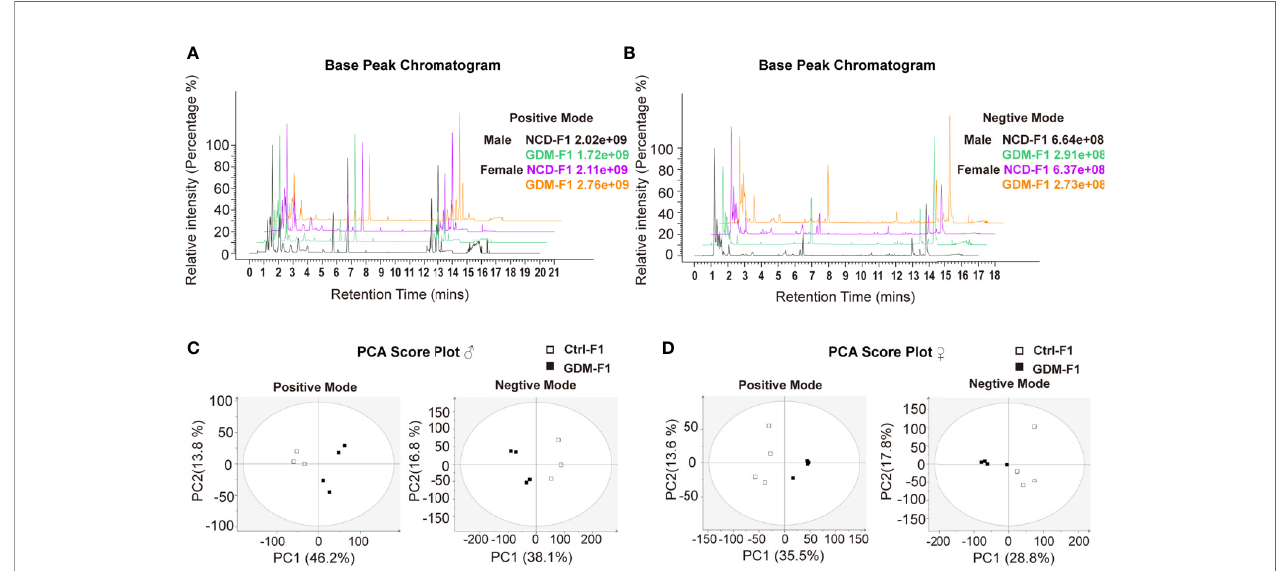
FIGURE 2 | BPI chromatograms and PCA score plot of UPLC-MS of fetal pancreas. (A) Representative positive BPI chromatograms of GDM-F1 and Ctrl-F1 fetal pancreas. (B) Representative negative BPI chromatograms of GDM-F1 and Ctrl-F1 fetal pancreas. (C) PCA showing clustering pattern among samples and biological replicates in male offspring. (D) PCA showing clustering pattern among samples and biological replicates in female offspring.